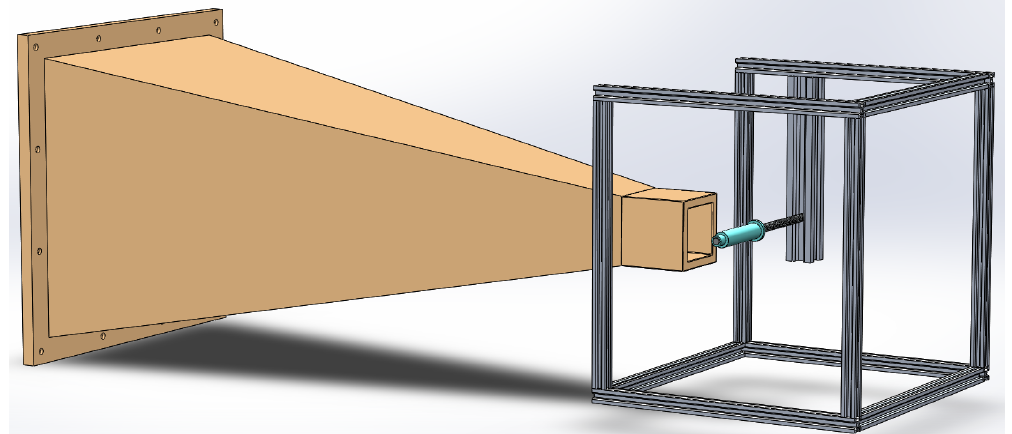
Figure 1. Schematic of experiment set up. Rig was made out of aluminium beams to withstand the force from wind tunnel and hold the porous coated